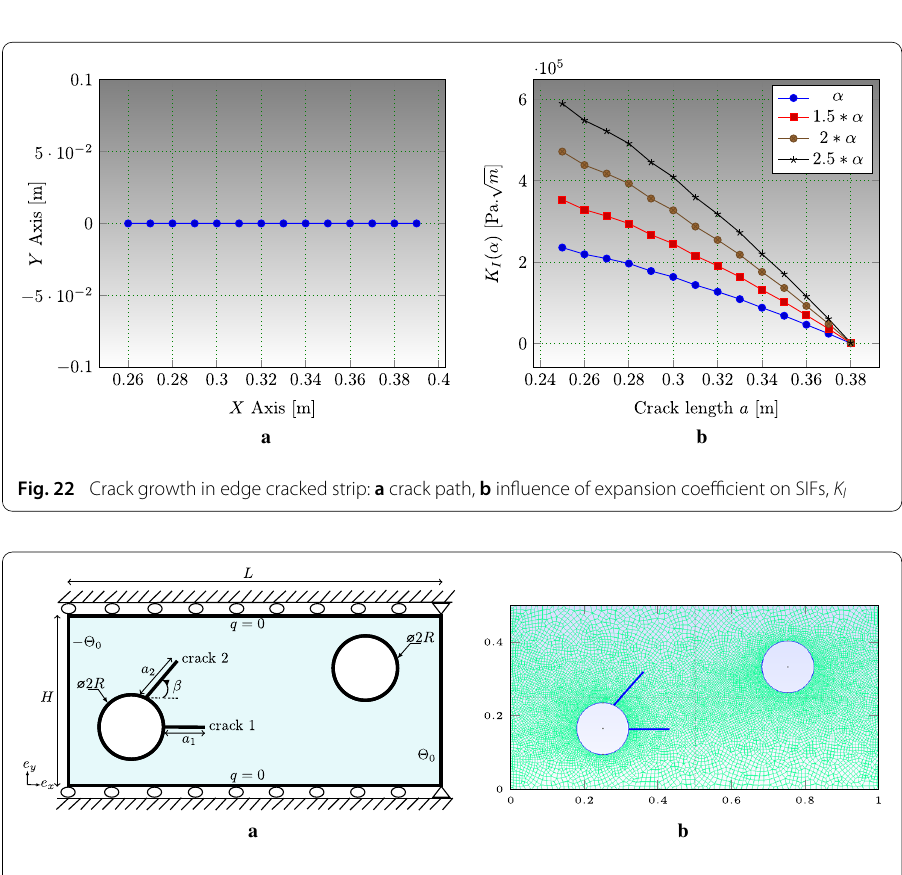
Rectangular plate with two circular holes and multiple